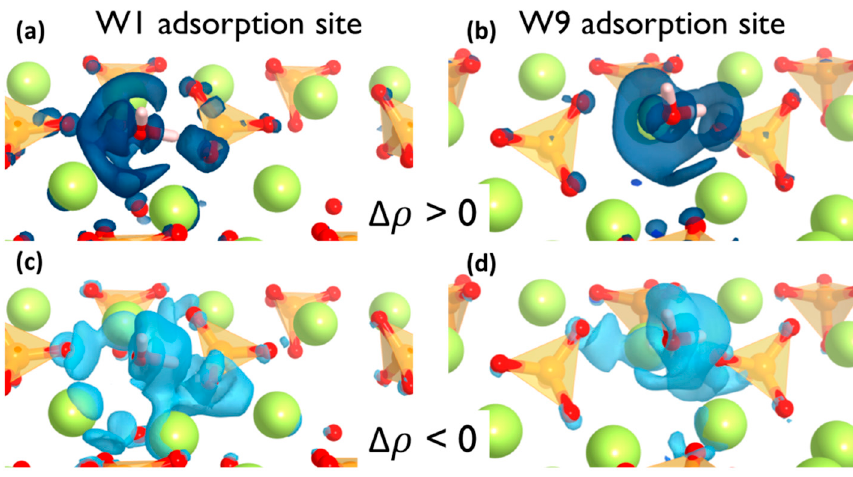
Figure 4. Isosurface plots of the electron density difference for W1 ( a , c ) and W9 ( b , d ) adsorption sites. Dark and light blue isosurfaces indicate the electron density surfeit and depletion, respectively.